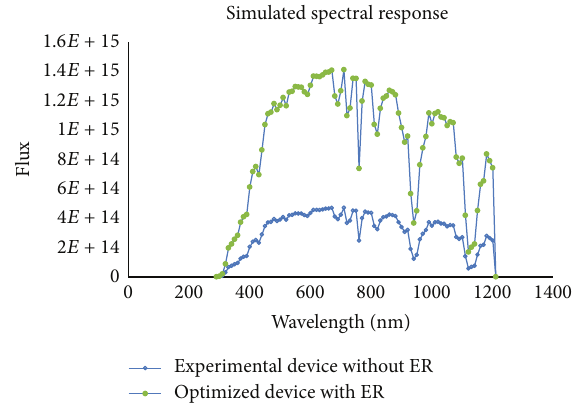
Figure 7: The simulated spectral response of an optimized CdTe cell with 100 nm extended region and a doping of 7 × 10 16 cm −3 .